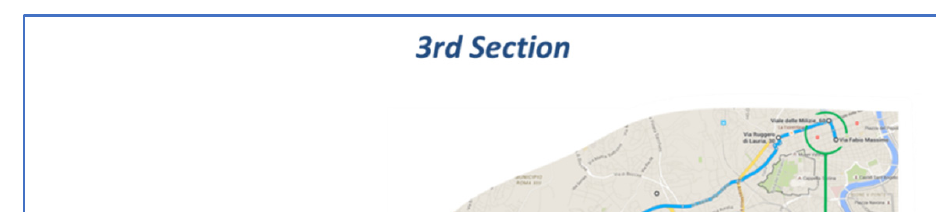
Figure 5. Altimetric profile of the test-path.